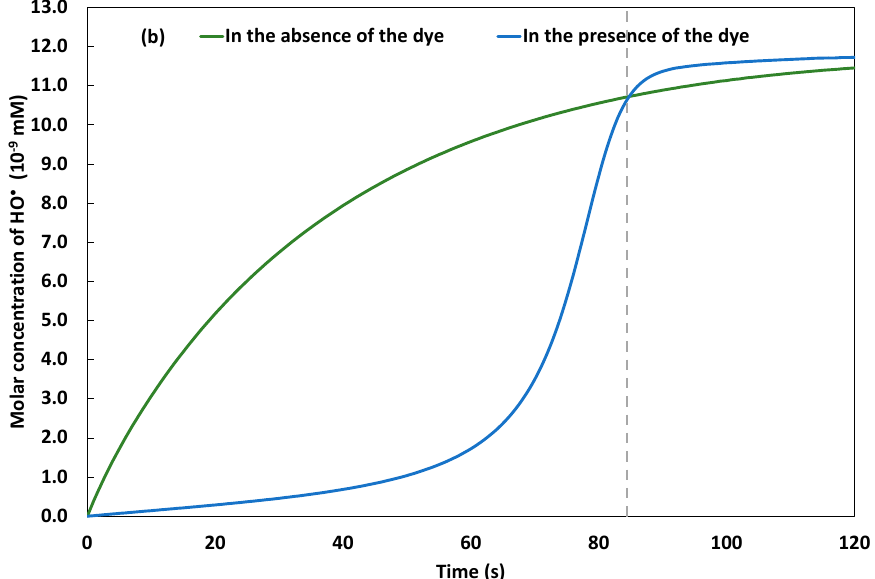
Figure 5. Simulated production of hydroxyl radical in the absence and in the presence of the dye (pH 3, initial concentration of the dye when present 5 mg ⋅ L − 1 and 162 µM of added H 2 O 2 ) (a) . Zoom on the first 120 s (b) . The dotted lines point out t = 86 s and t = 155 s.